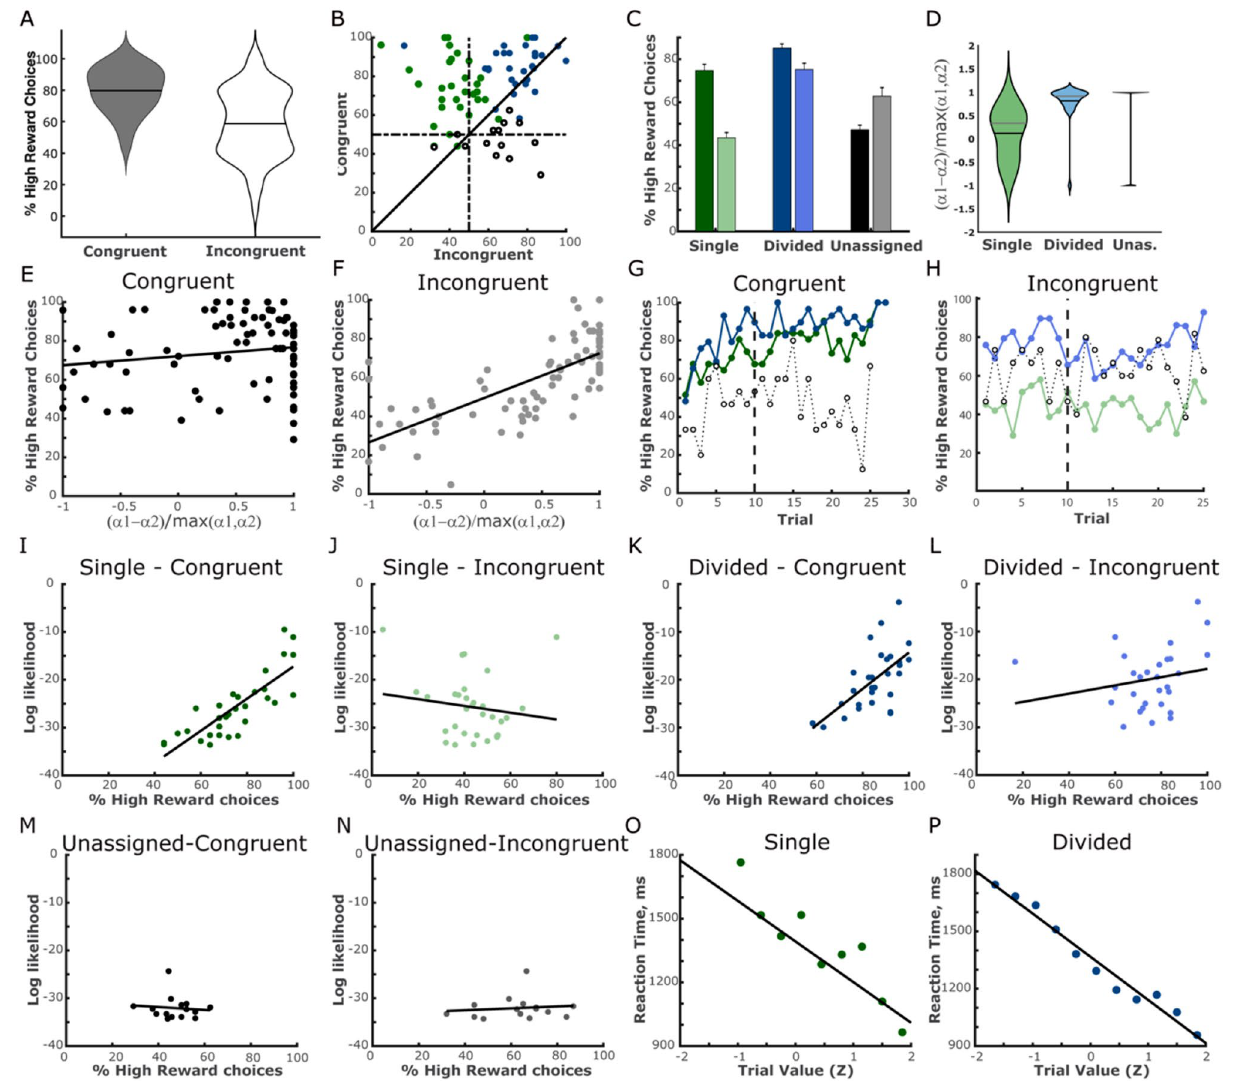
Figure 2. Individual differences in learning strategies. ( A ) Distributions of the proportion of high-reward choices in congruent (dark grey) and incongruent (white) conditions, showing a bimodal distribution of high- reward choices in the incongruent pair condition. The mean of each distribution is indicated by a black line. ( B ) Individual scores on congruent and incongruent trials of subjects assigned to the ‘single strategy’ (green), divided strategy (blue) and unassigned (empty marks). ( C ) Proportion of high-reward choices divided according to learning strategy, depicting single strategy model scores for congruent (dark green) and incongruent (light green) pairs, scores of the ‘divided strategy’ group for congruent (dark blue) and incongruent (light blue) conditions, and unassigned participants (in dark and light grey). The lowest high-reward choice scores were evident in the ‘single strategy’ group for the incongruent pair. ( D ) Distributions of relative differences between learning rates calculated of experienced and observed conditions for each group. ( E – F ) Correlations between relative learning-rate differences (using a two learning-rate model) and learning scores for congruent (left) and incongruent (right) pairs. ( G – H ) Learning curves of the single (green), divided (blue) and unassigned (grey) groups for congruent and incongruent stimuli pairs. The dotted line at trial 10 represents the end of the predominantly experienced stage. Panels ( I – N ) depict correlations between subjects’ proportion of high-reward choices and the quality of the model fit (log likelihood of subjects’ choices) for each group and each condition. Note that log-likelihoods in panels ( I ) and ( J ), as well as in ( K – L ) and ( M – N ) are identical, as the model fit was performed across congruence conditions. ( O – P ) Mean reaction-times of stimulus choices during the decision- making task binned as a function of calculated high-reward stimulus values for the single-strategy group (r = − 0.91) and the divided-strategy group (r = −